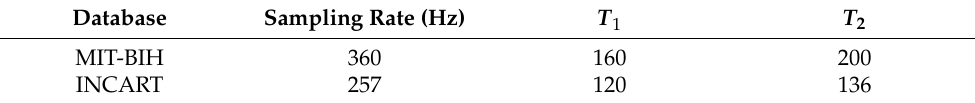
Table 3. Sampling rates, values of T 1 and T 2 for both MIT-BIH and INCART